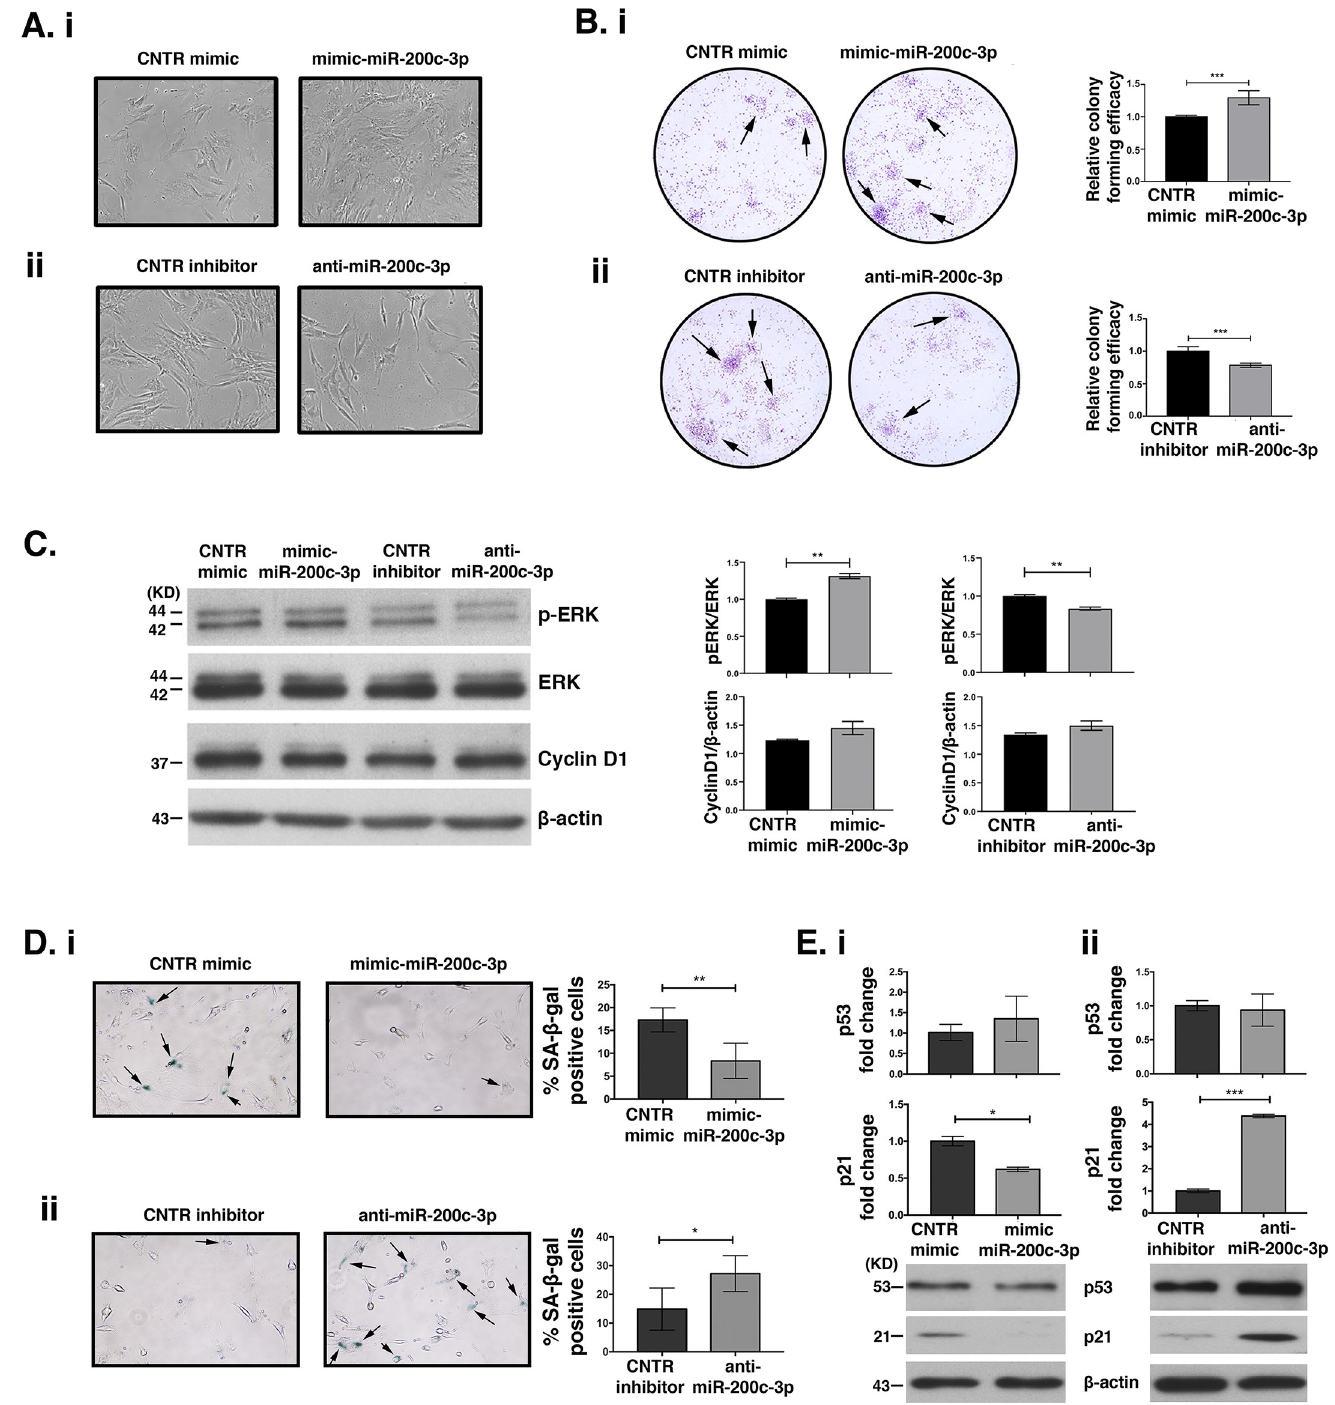
Fig 4. MiR-200c-3p affects proliferation and regulates senescence through p53, p21 expression in ASCs. A. Representative images of ASCs transfected with mimic at P4, (low miR-200c-3p) (i) or inhibitor miR-200c-3p at P9, (high miR-200c-3p) (ii) and their corresponding controls. The images were taken at 72 h post- transfection at 40x magnification. B. Clonogenic assays of ASCs transfected with miR-200c-3p mimics (i) and anti-miR-200c (ii) or their respective controls. Cells were stained with crystal violet and subsequently photographed. Absorbance at 595 nm was measured to estimate the optical density in each condition. The black arrows indicate colonies formation. SD ± is the mean of optical density of each condition. The experiment was repeated twice and each condition in triplicates and p values were calculated with unpaired t test, ��� p < 0.001. C. Expression of p-ERK, ERK, Cyclin D1 was studied by WB in ASCs transfected either with mimic at P4 or with anti-miR-200c-3p at P9. On the right, densitometry analysis measures the levels of p-ERK normalized to ERK and Cyclin D1 normalized to β -actin. SD ± is the